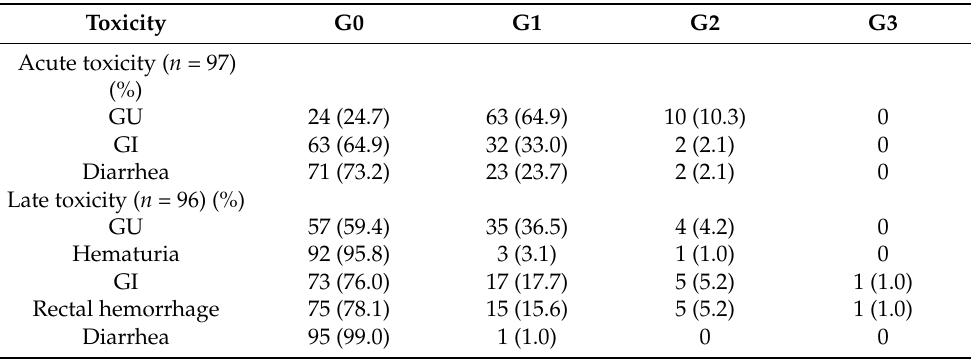
Table 4. The incidence levels of toxicities according to the common terminology criteria for adverse events, version 4.0.